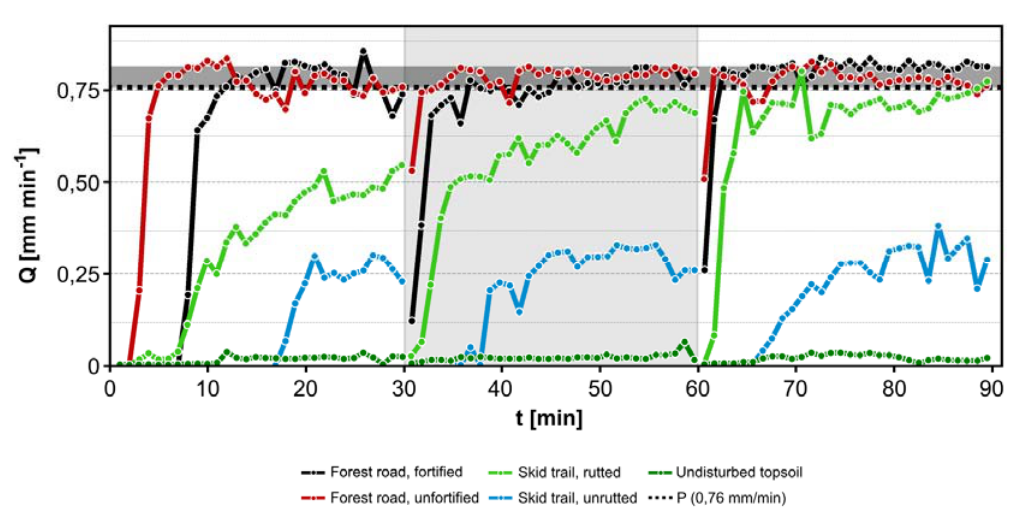
Figure 4. Exemplary hydrographs for different surface types. Indicated rainfall intensity error (+0.05 mm ∙ min − 1 ) calculated on the basis of fortified forest road simulation. Q = Runoff volume per minute; t = Time.